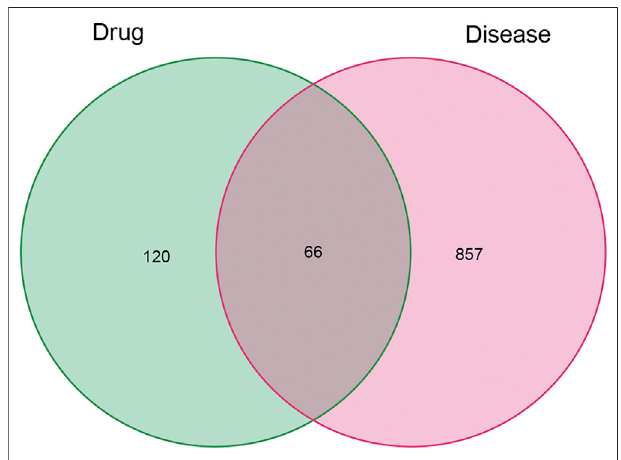
FIGURE 2 | Venn plot showing the intersections of herbs and HT- related genes.